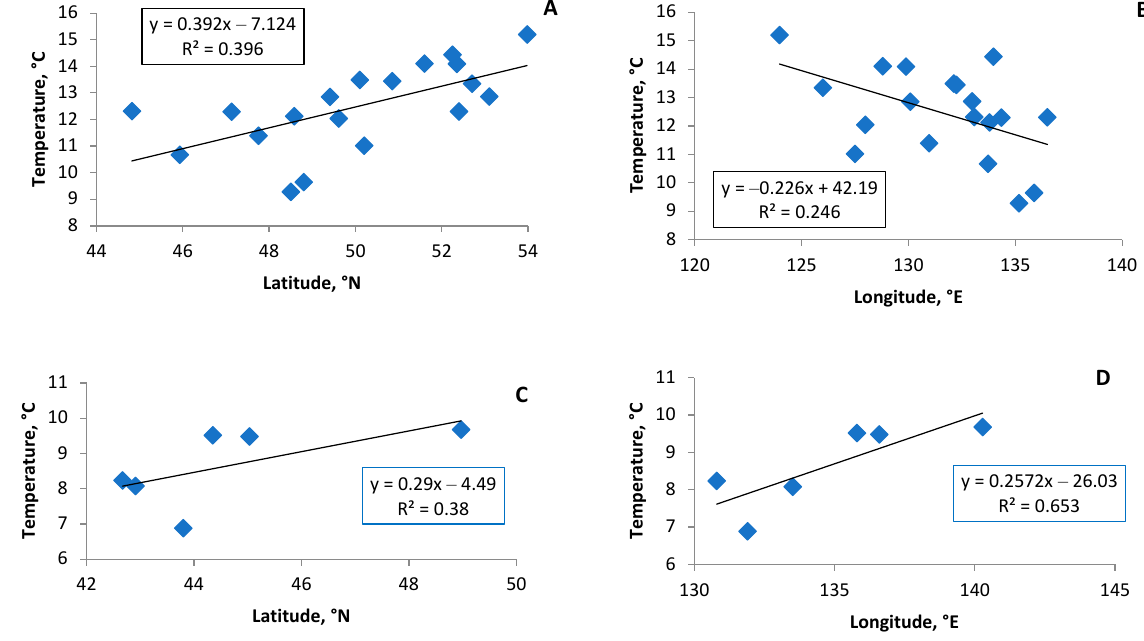
Figure 3. Scatterplots of diurnal temperature range (DTR) vs. latitude ( A , C ) and longitude ( B , D ) for locations at the southern part of the Russian Far East for the period 2000–2019; ( A , B ) continental weather stations, ( C , D ) maritime weather stations. Black solid line is plotted as the least-square linear regression.